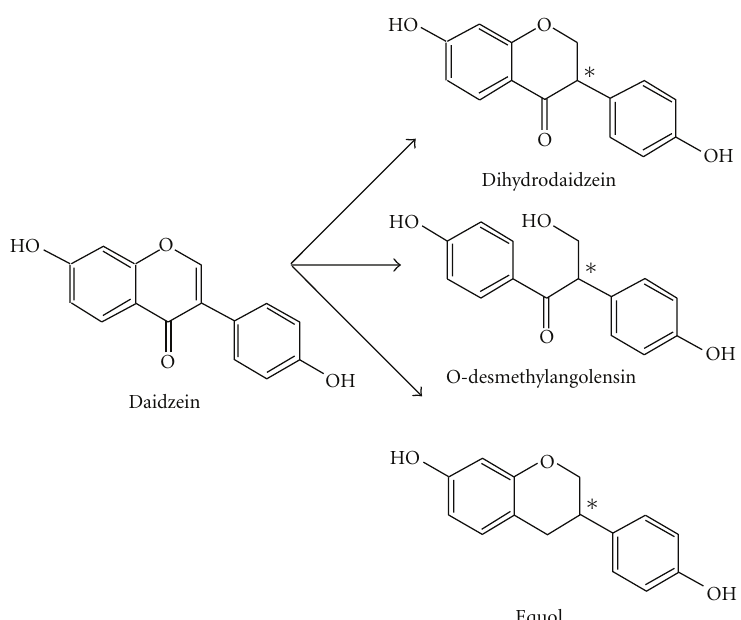
Figure 2: Metabolites of daidzein. Daidzein is converted by anaerobic bacteria in the large intestine to several metabolites, dihydrodaidzein, O-desmethylangolensin, and equol. Each of these metabolites has a chiral center at C-3 due to the reduction of the Δ 2 − 3 double bond (marked with a star ∗ ). Equol is found as its S-(-)-equol enantiomer. The chirality of the other daidzein metabolites is not known.